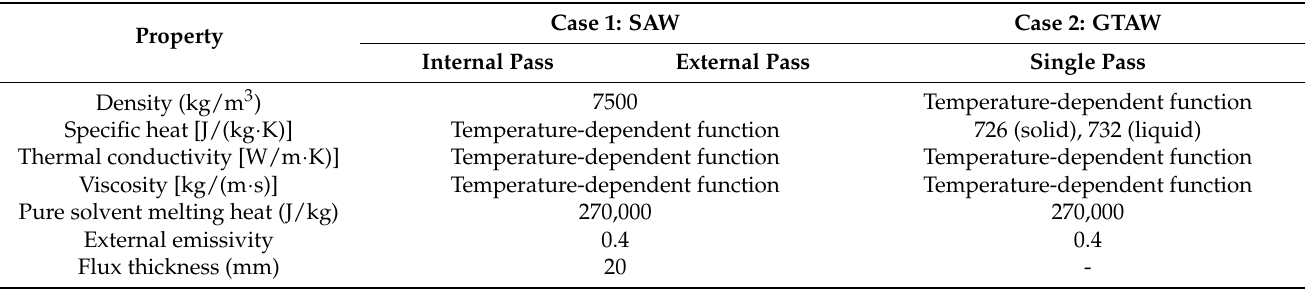
Table 1. Submerged arc welding (SAW) and gas tungsten arc welding (GTAW) parameters used for the heat transfer model.